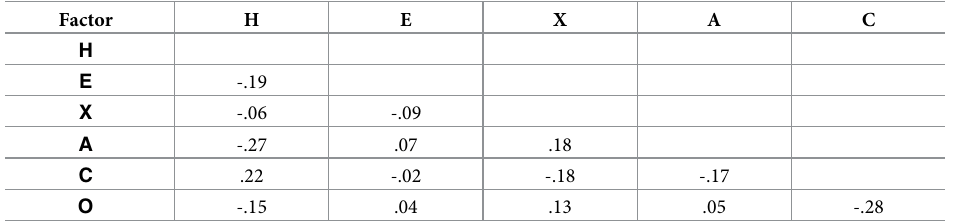
Table 3. Correlations among the six factors extracted from the items (EFA) of the 192-item HEXACO-MSI-E (Study 2). Factor H E X A C H -.19 -.06 -.09 -.27